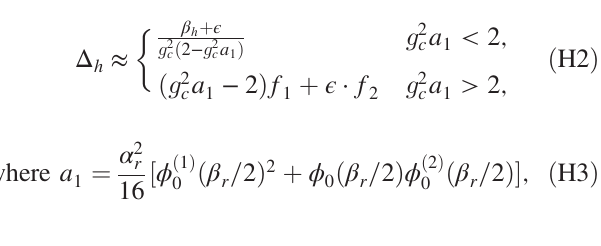
FIG. 12. The role of biases. (a) FP solutions as a function of increasing β β . Dashed lines correspond to FP solutions that are unstable (time-varying states). (b) The leading edge of the spectrum corresponding r to the FP solutions calculated in (a); the FP solution is unstable when the leading edge is positive. (c) Similar to (a) but for β shades of blue correspond to different values of β becomes unstable (circles) compared with the perturbative solution predicted by Eq. (H2) (solid lines). (f) FP solution as a function of β and β . The orange line indicates the stability line — i.e., regions on top of the orange line correspond to unstable or time-varying h